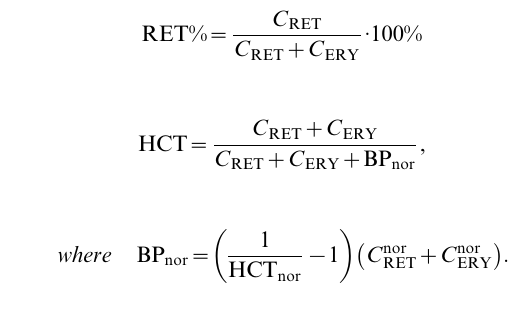
EPO chemotherapy disease reference